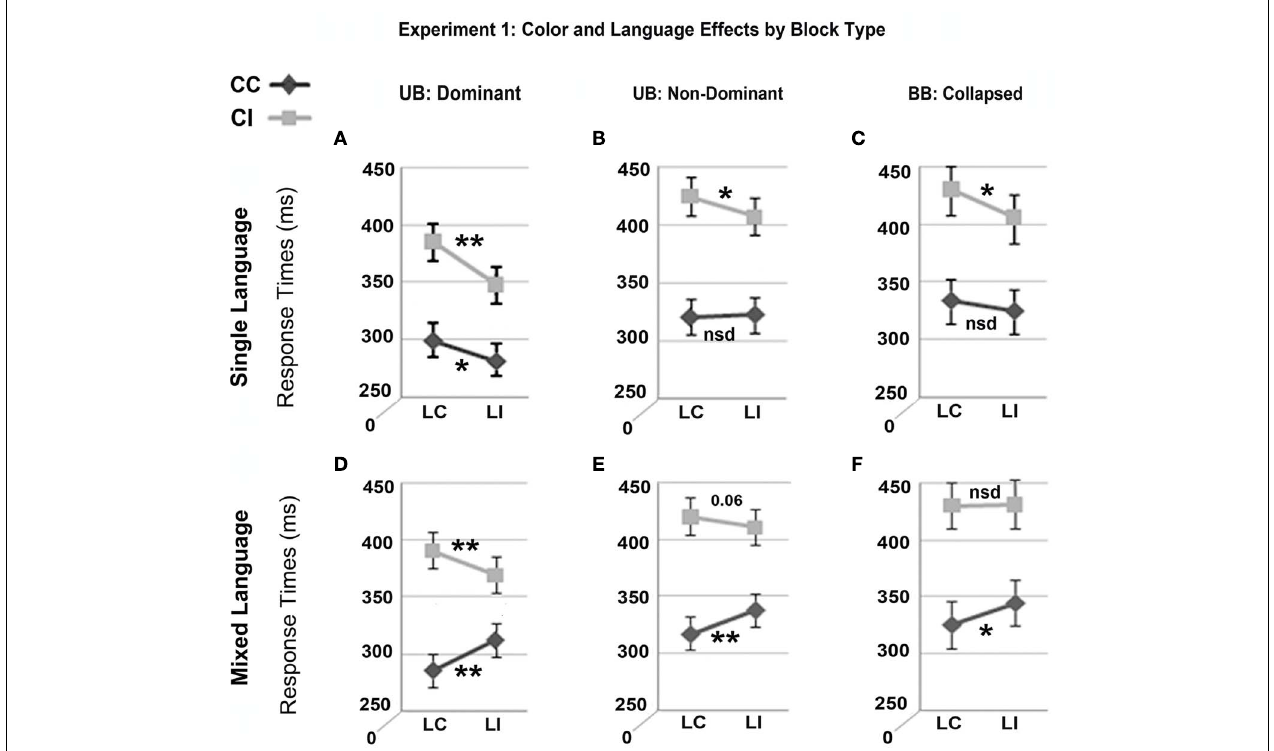
and English; panels D–F show results for stimuli presented alternately in Spanish and English in the same block. In all six plots, the effect of color congruence was significant at p ≤ 0.001 and this effect was significantly larger within than between languages at p ≤ 0.05. All other effects noted: ** p ≤ 0.001; * p ≤ 0.050; nsd, non-significant differences. CC, color congruent; CI, color incongruent; LC, language congruent; LI, language